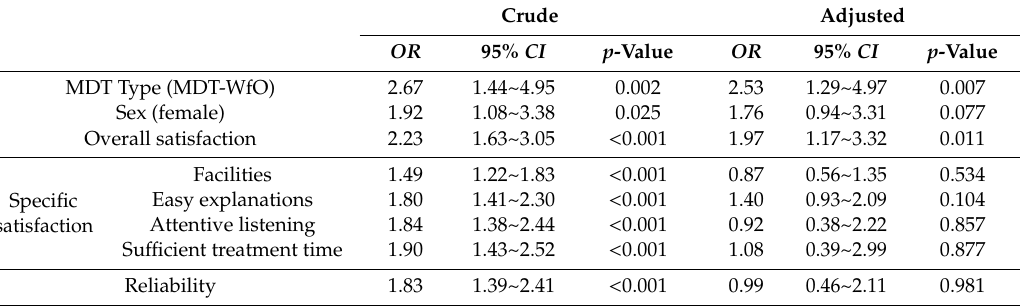
Table 5. Results of logistic regression analyses for perception